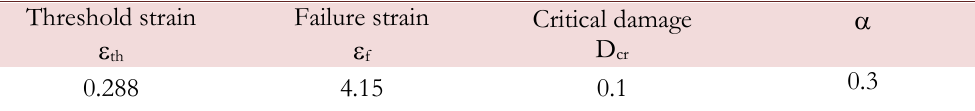
Table 2: Summary damage model parameters .